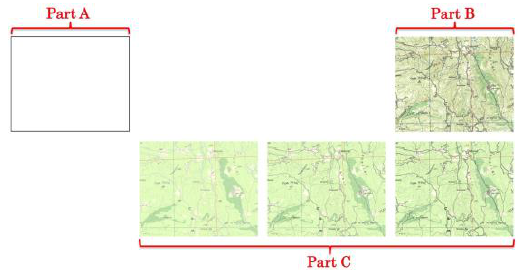
Backgrounds with different level of information used for the performance of the three experimental parts (Part A, B, & C). The resolution of screen and stimuli are 1280x1024pixels while the selected size corresponds approximately to the physical dimensions of 4.5x4.5mm in stimuli monitor and a 15x15pixels compact and black dot serves as the moving point symbol of the